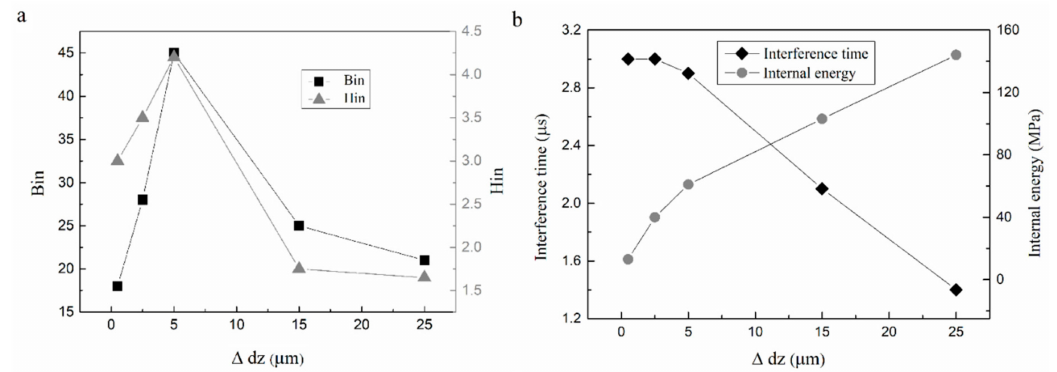
Figure 7. Other interference results of twice scratching with di ff erent Z-axis spacings along the DOC direction, ( a ) Bin and Hin , ( b ) and nterference